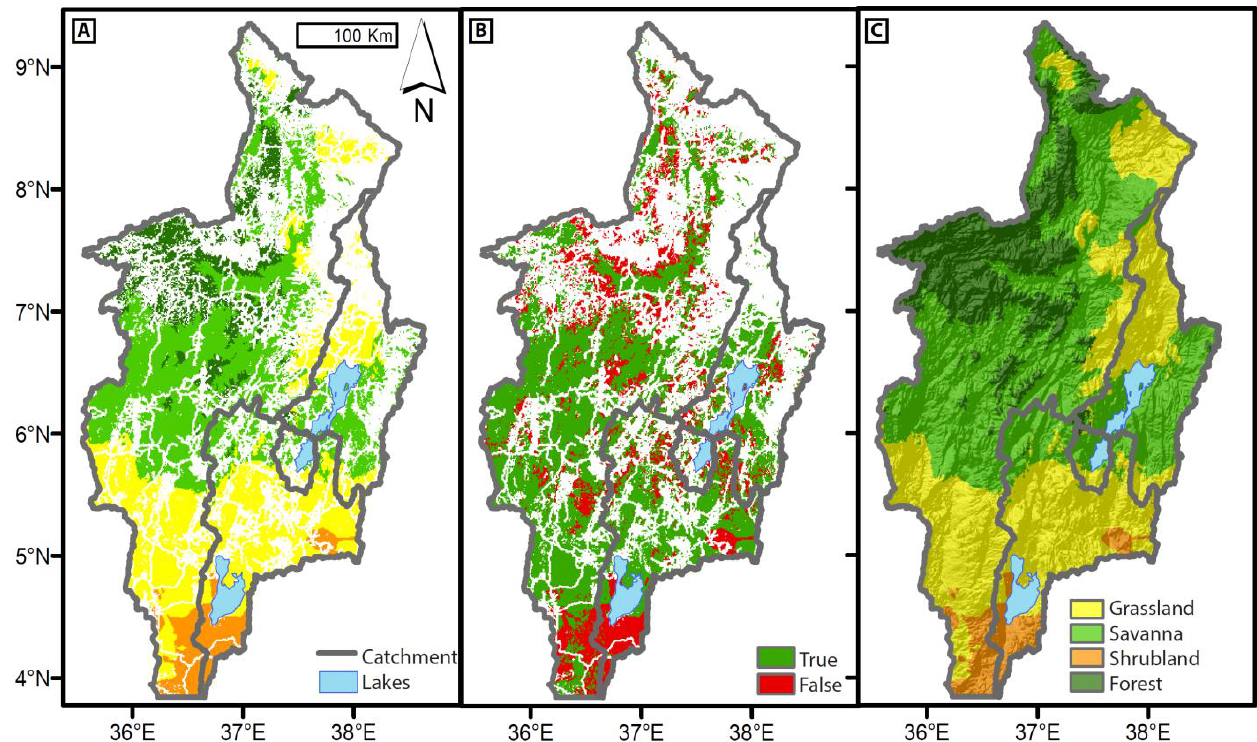
Figure 4. Spatial model performance, extrapolation and PI LC: ( A ) Result of the LC-BRT using the original data_tr dataset. ( B ) Model performance with correct (green) and incorrect (red) classified data points, based on comparison of panel 3 of Figures 3A and 4A. ( C ) Resulting extrapolated LC representing the PI scenario using the original data_pr dataset and LC-BRT.